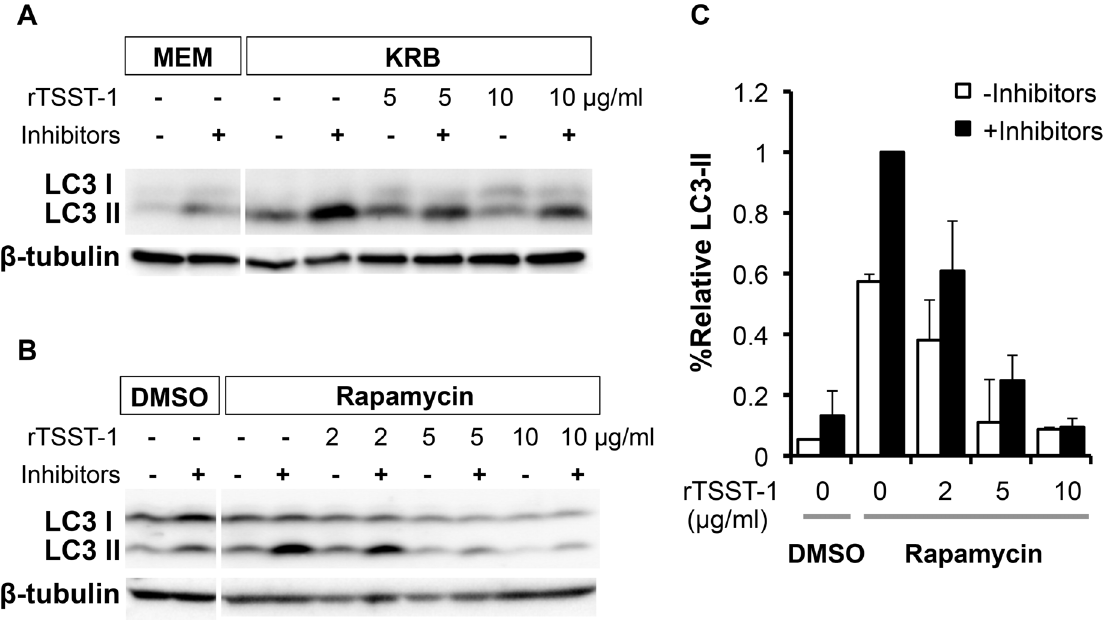
Figure 5. rTSST-1 suppresses LC3-II accumulation in the autophagy induced HeLa 229 cells. Autophagy in HeLa 229 cells was induced by nutrient-starvation (KRB) (A) or rapamycin (B and C) with or without the addition of lysosomal protease inhibitors and rTSST-1. Cells in MEM or DMSO were used as controls. At 4 h of induction, LC3-II was detected by Western blotting (A and B). (C) The intensity of LC3-II band was quantified by normalizing with the intensity of b -tubulin band. The amount of LC3-II was calculated relatively to that from autophagic induction condition with lysosomal protease inhibitors, which set to 1.